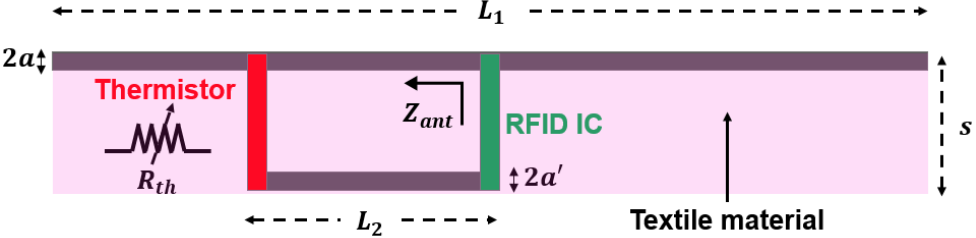
Figure 1. Configuration of the RFID temperature sensor tag integrated into a textile yarn